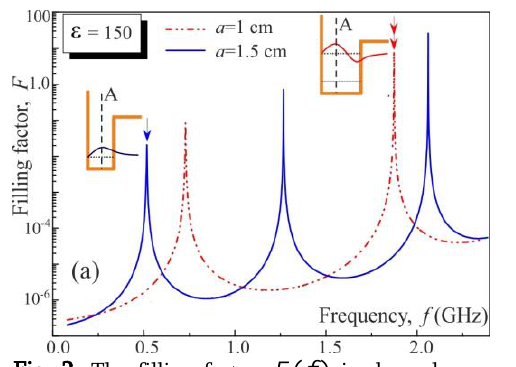
Fig. 2. The filling factor ) ( f F in dependence on Fig. 1. The concept of overcoming of radio communi- the transmitted signal frequency (normal incidence on cation blackout: profile of the "potential barrier" vehicle surface). Calculations are made for 10 = d cm )) ( 1 ( ) ( z z V  −  containing a vehicle surface (I), dielec- and 150 = d  . The inset to figure schematically repre- tric layer (thickness a) with embedded antenna (II) and sents parts of the corresponding wave functions of sta- plasma sheath (III). (IV) corresponds to the region of infi- tionary states within the framework of the optical- nite motion of the electromagnetic wave (atmospheric air). mechanical